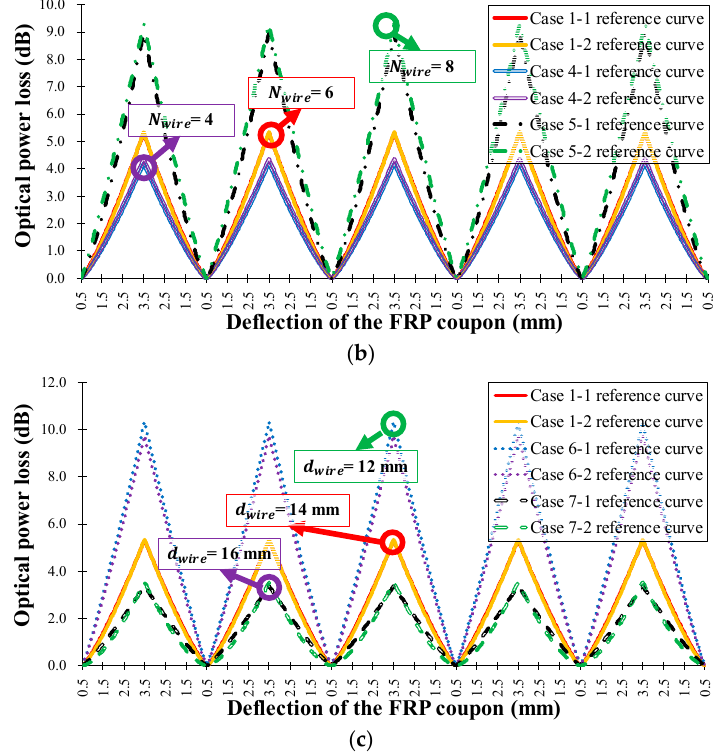
Figure 13. Measured FOS head optical power loss according to the three-point bending deflection of the FRP coupon of the seven types of FRP sensor head in Table 1. ( a ) R wire = 0.75, 1.00, and 1.50 mm, N wire = 6, d wire = 14 mm; ( b ) R wire = 1.00 mm, N wire = 4, 6, and 8, d wire = 14 mm; ( c ) R wire = 1.00 mm, N wire = 6, d wire = 12, 14, and 16 mm.